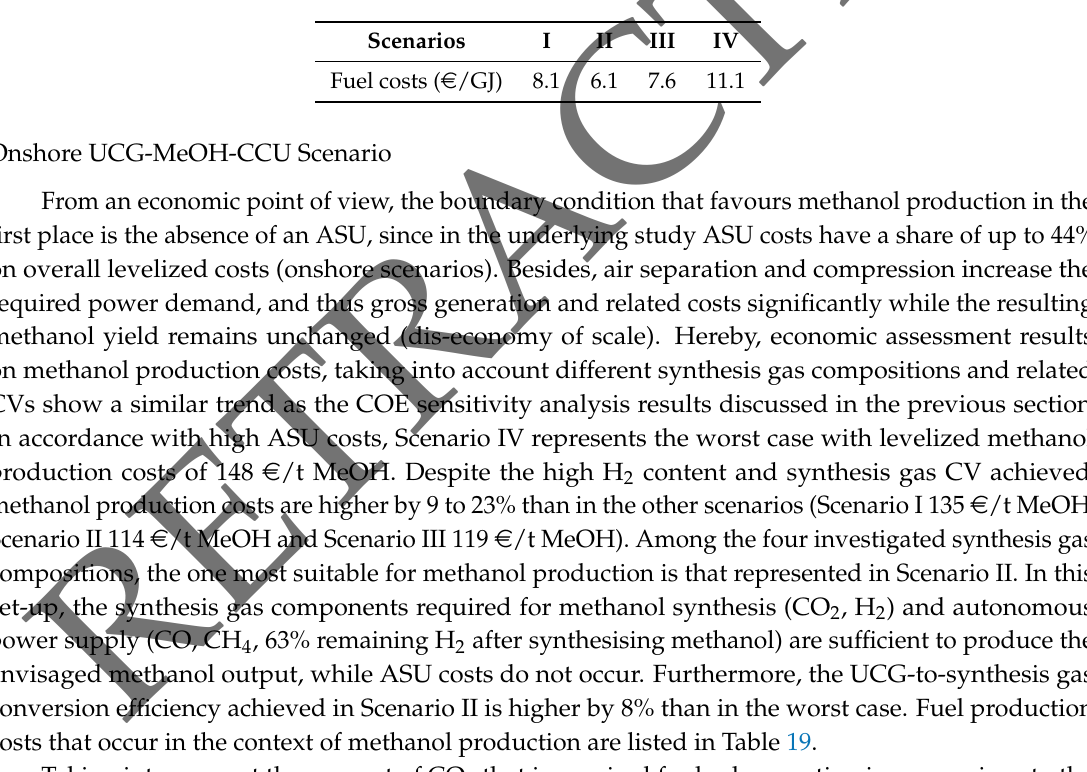
Table 18. Fuel production costs for electricity production considering different synthesis gas